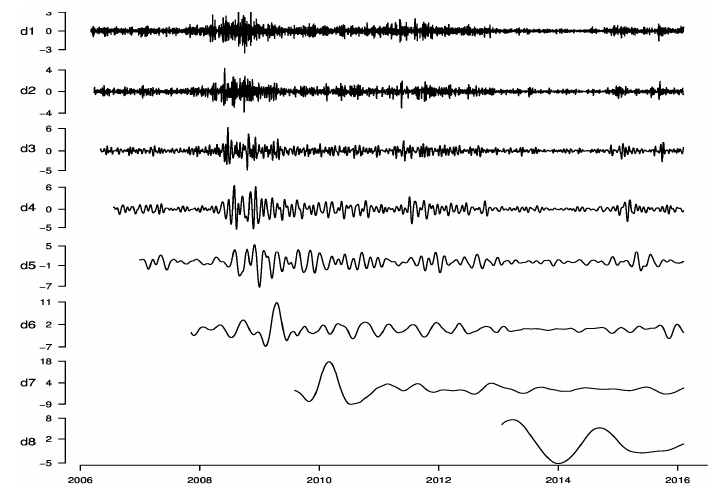
Figure C1. MODWT decomposition for the futures estimated by a stochastic model ( top ), futures obtained as the longest maturity ( middle ) and spot prices ( bottom ). The wavelet coefficient vectors, d1, d2, . . . , d8 are associated with variations on scales of 1, 2, 1024 days.